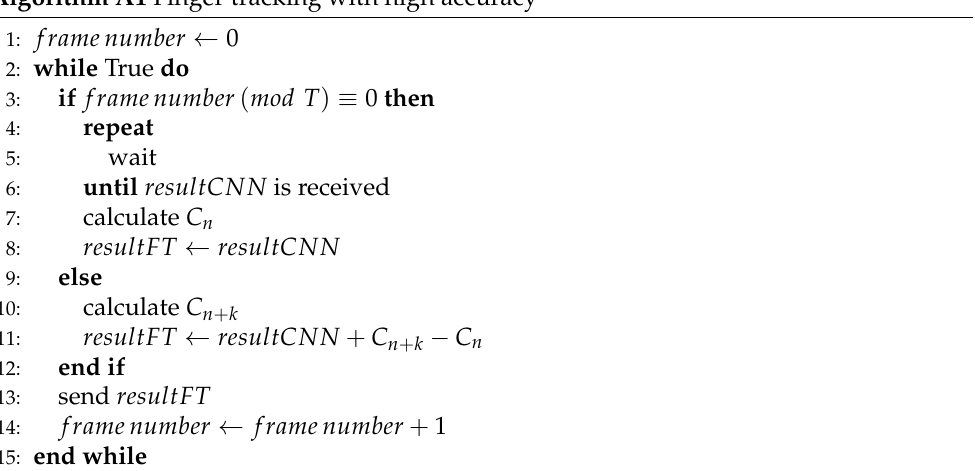
Algorithm A1 Finger tracking with high